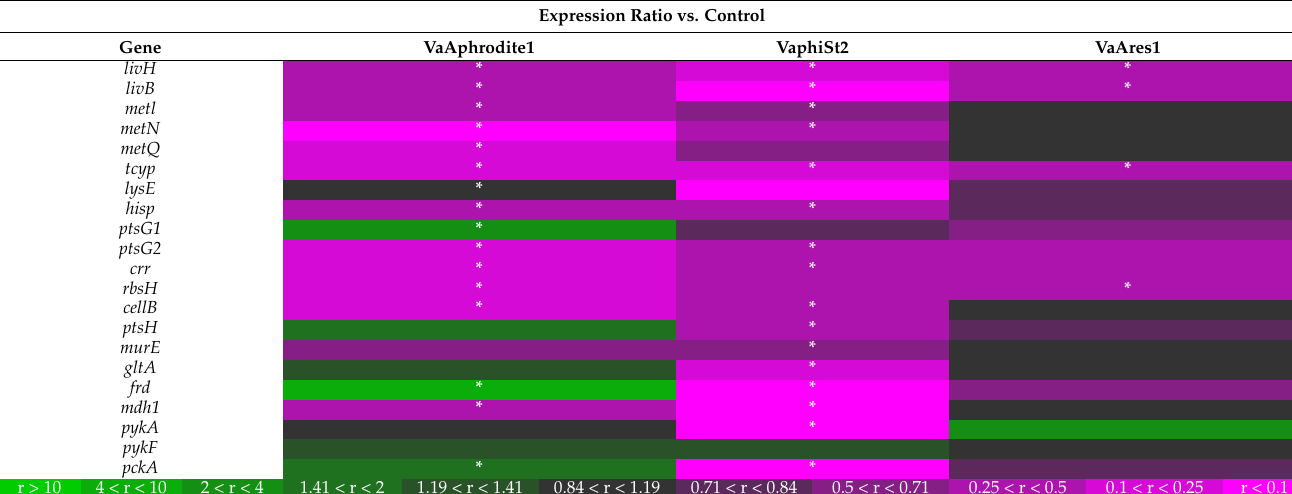
Table 4. Heat maps of relative transcript levels of some of the genes that were altered for every resistant strain expressed as a ratio vs. Control strains (r > 1 represents upregulation, 0 < r < 1 represents downregulation). Asterisks indicate statistically significant differences compared to control (wild-type) strains (Student’s t -test; p <